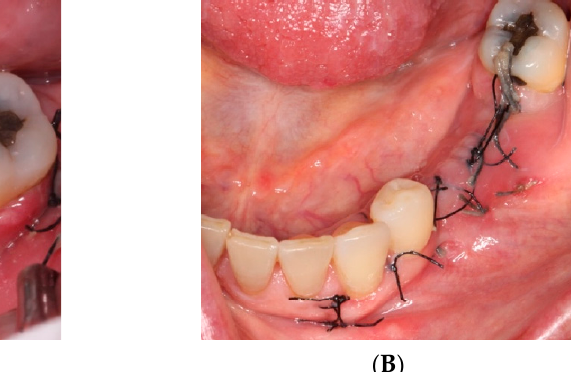
Figure 8. ( A ) Control at 7 days. ( B ) Control at 14 days, a good appearance of the wound is observed.